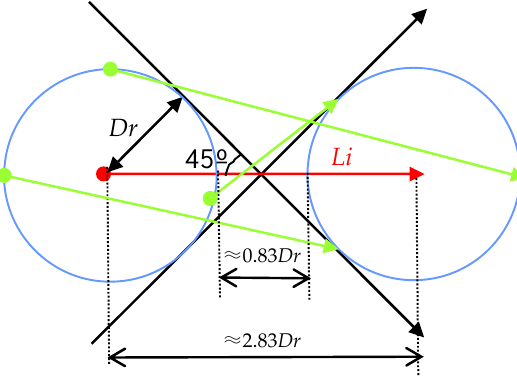
Figure 3. The length constraint of Li (the dots represent O, and the arrows represent D).